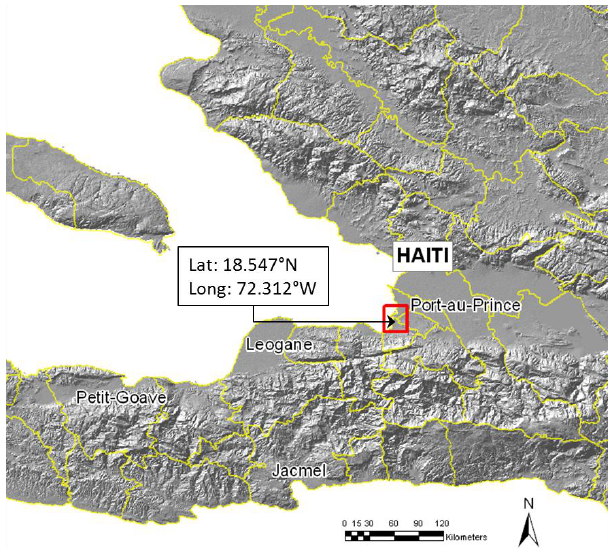
Fig. 1. Location of the study area in Port-au-Prince. Figure 1. Location of the study area in Port-au-Prince 25 between 12 January and the end of March 2010. The great- est number of reports were received up to 23 January, and dropped off almost immediately thereafter.